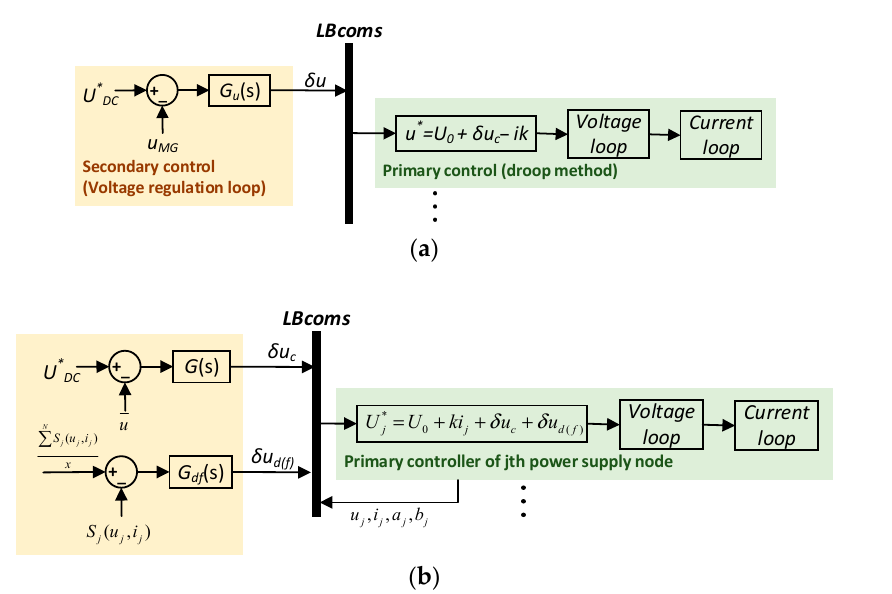
Figure 13. Block diagrams of: ( a ) the conventional hierarchical method; and ( b ) the hierarchical control-based OPF realization method of [136] for DCMGs.